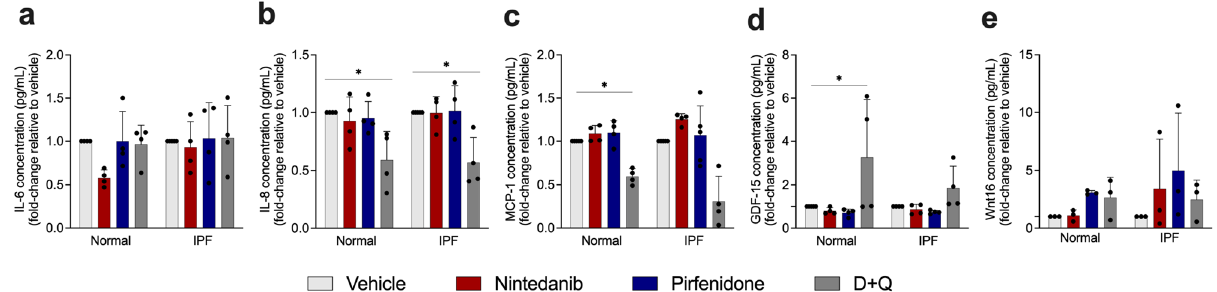
Figure 6. SOC do not have an impact on SASP release. Effects of treatment for 24 with nintedanib (300 nM), pirfenidone (2.5 mM), D + Q (20 μM/15 μM) or control (vehicle; DMSO 0.05%), on IL-6 ( a ), IL-8 ( b ), MCP-1 ( c ), GDF-15 ( d ), and Wnt16 ( e ) levels in the supernatant of normal and IPF senescent lung fibroblasts. Data are presented as mean ± SD (n = 3 or 4 per group). p values were calculated using one-way ANOVA followed by Tukey’s test. p* < 0.05 and **p < 0.001 as indicated by the